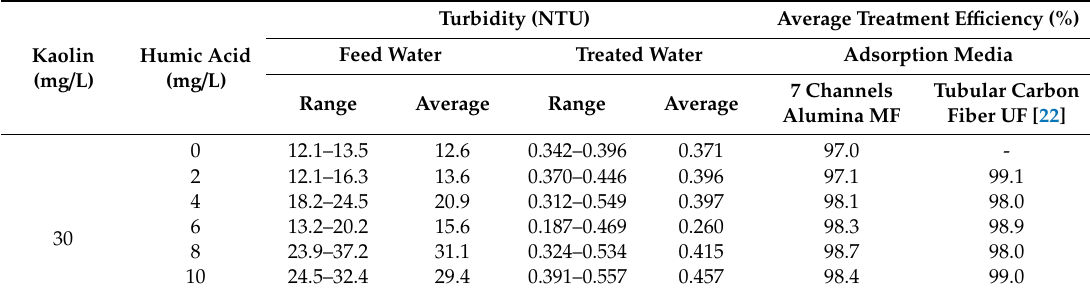
Table 3. Water quality and treatment e ffi ciency of turbidity in the hybrid process of 7-channel alumina MF (HC10) and PP beads for the e ff ect of humic acid concentration as compared with results of tubular carbon fiber UF (C005)